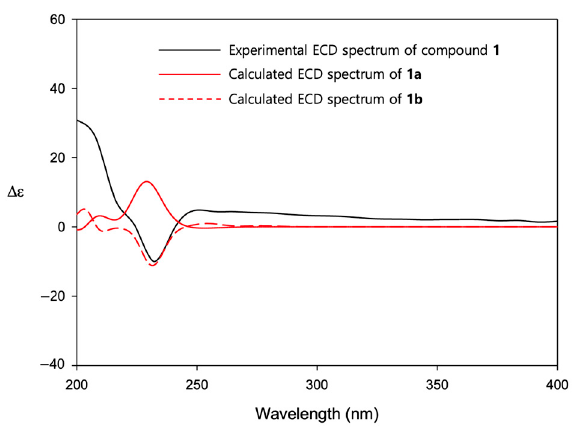
Figure 3. Comparison of calculated and experimental ECD spectra of 1 .